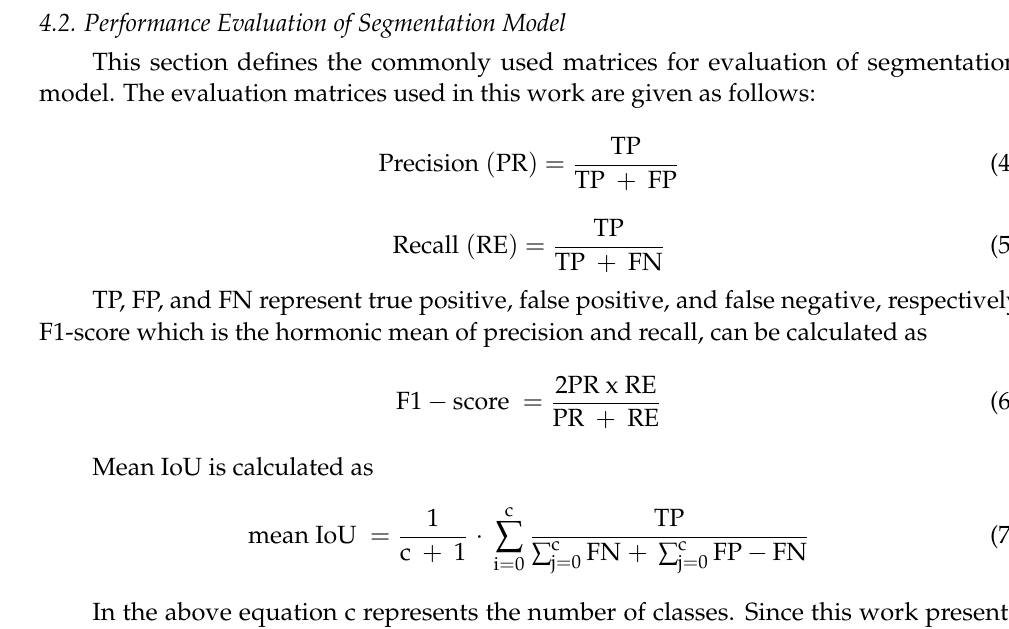
Figure 7. Result visualization: ( a ) Segmentation at different epochs; ( b ) Segmentation of validation